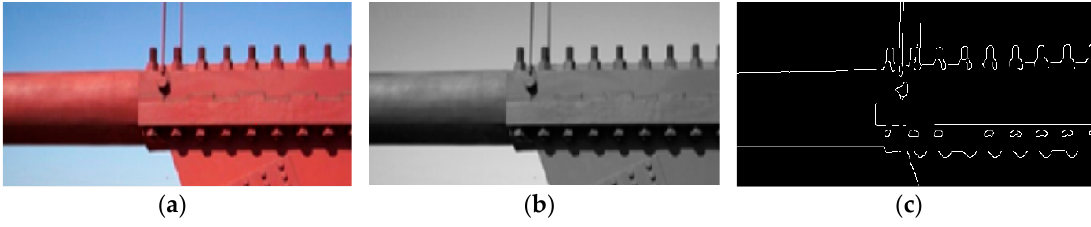
Figure 2. Processed image: ( a ) Original image; ( b ) Grayscale image; ( c ) Edges in the image.